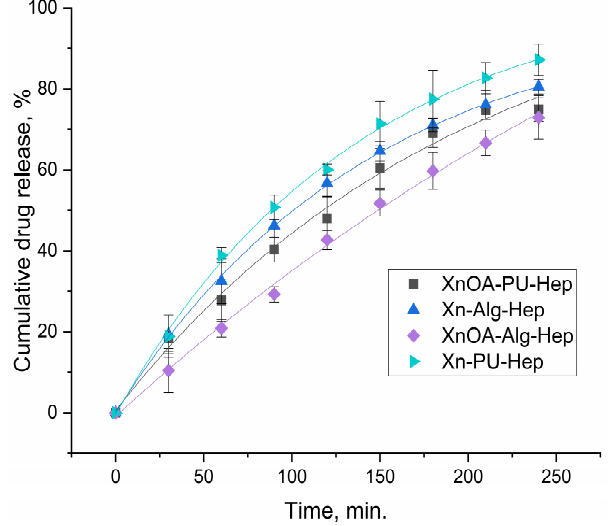
Figure 4. Cumulative drug release data for the tested materials according to the Korsmeyer–Peppas model. Table 2. The kinetic parameters for drug release experiments.